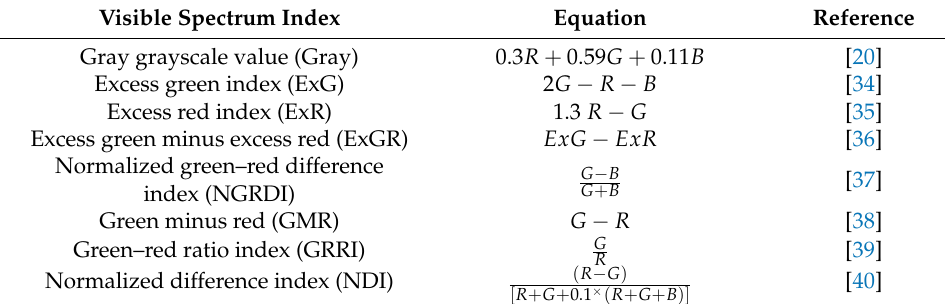
Table 1. Visible spectrum index